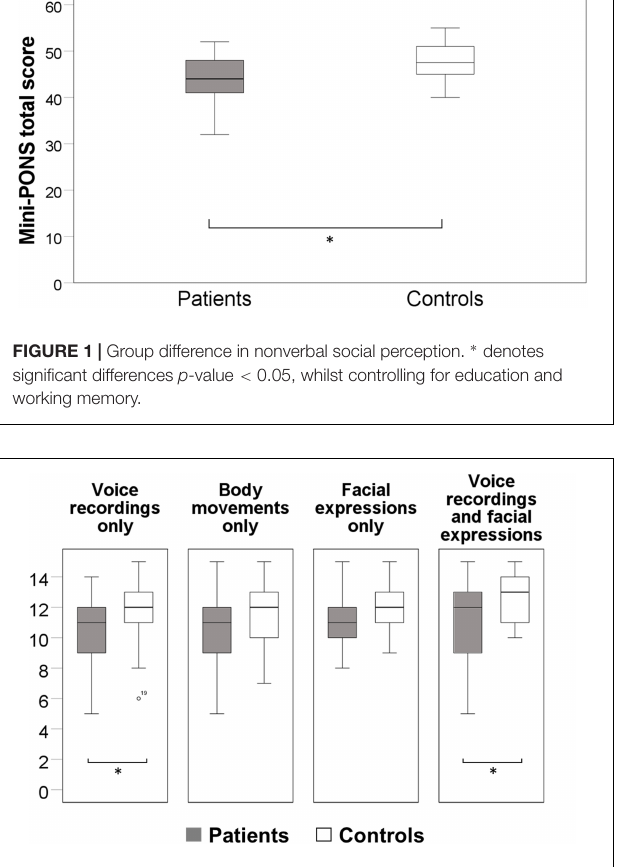
FIGURE 2 | Group differences in emotional prosody, face and body movement perception. ∗ denotes significant differences p -value < 0.05 whilst controlling for education and working